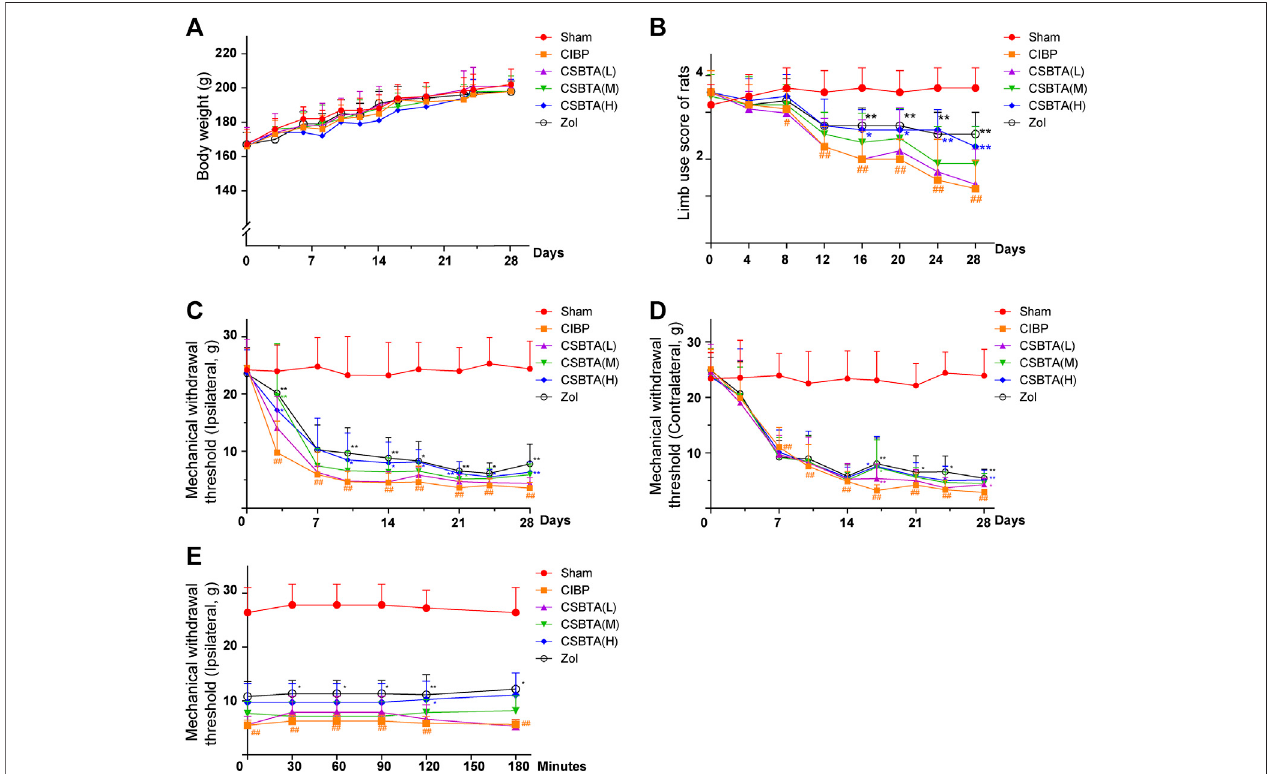
FIGURE1| EffectofCSBTAtreatmentonthebodyweight,limbusageandmechanicalallodyniainrats.RatsweredosedwithCSBTA(25,50,100 mg/kg/day)and Zol (250 µg/kg/day, intravenous injection). (A) The body weight ofrats ( n (cid:2) 7). (B) The limb use score during spontaneous ambulation ( n (cid:2) 7). (C) Mechanical withdrawal threshold changes of the rat ipsilateral hind paws in different groups ( n (cid:2) 7). (D) Mechanical withdrawal threshold changes of the rat contralateral hind paws in different groups( n (cid:2) 7). (E) Onthe14thday,Von-Freytestwasperformedat0,0.5,1.0,1.5,2.0,3.0 hafterasingleadministrationofCSBTA( n (cid:2) 5).Datawaspresentedas means ± SD. # p < 0.05, ## p < 0.01 vs. the Sham group. * p < 0.05, ** p < 0.01 vs. the CIBP